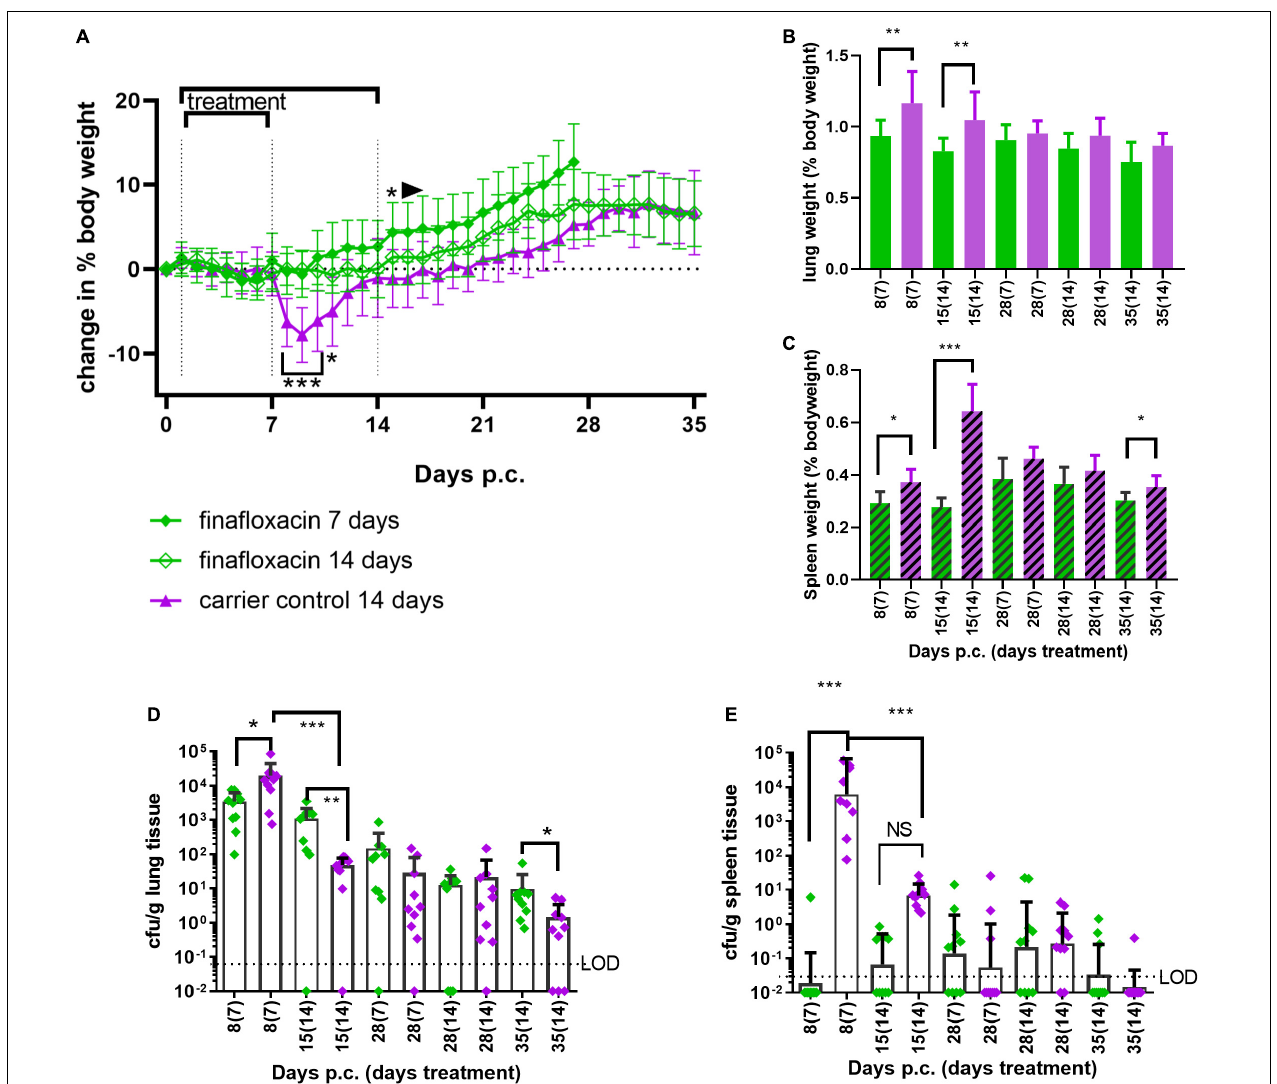
FIGURE 6 | Efficacy of 7 or 14 days of finafloxacin treatment following infection with C. burnetii . At 24 h post-challenge mice were treated with finafloxacin (30 mg/kg) or the carrier, once a day orally for 7 or 14 days. (A) Weight loss compared to baseline, (B) lung weight as a percentage of body weight, (C) spleen weight as a percentage of body weight, (D) bacterial burden for lung by viable count, and (E) bacterial burden for spleen by viable count. Mean and SEs are shown for weights, geometric mean and SD for cfu, limit of detection marked LOD. * p < 0.05, ** p < 0.01, *** p <